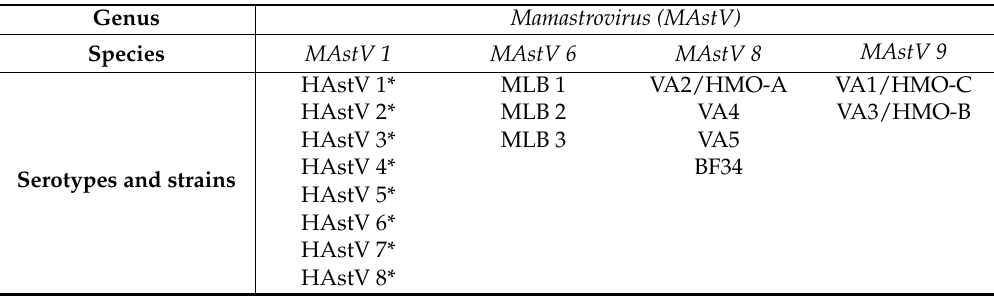
Table 1. Human astroviruses